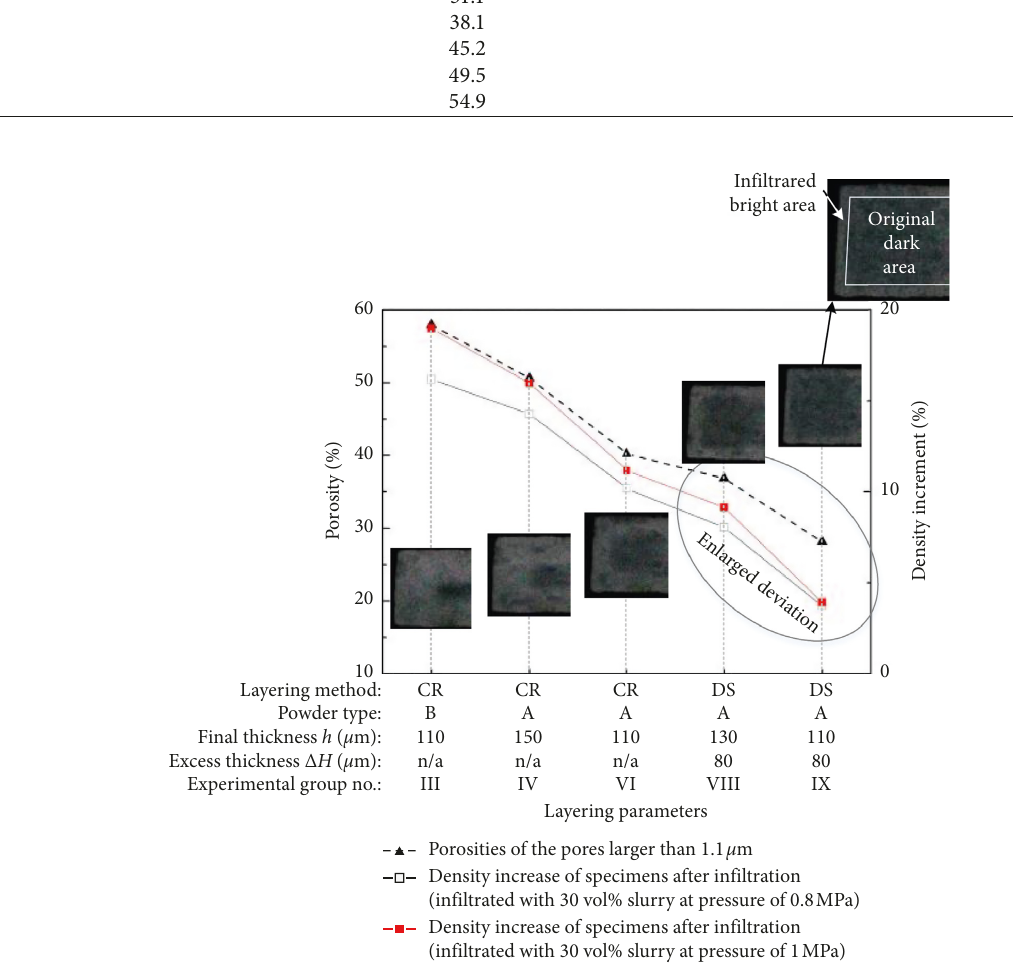
Figure 15: Relationship between the specimens’ density increments induced by infiltration and the porosities of large pores ( presintered